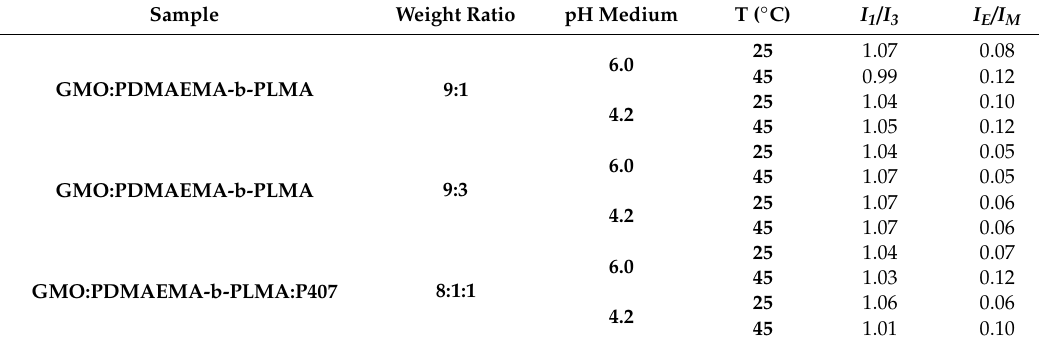
Table 6. Fluorescence intensity ratios I 1 / I 3 (indicating micropolarity) and I E / I M (indicating microfluidity) for a pyrene probe incorporated into the GMO prepared nanosystems.